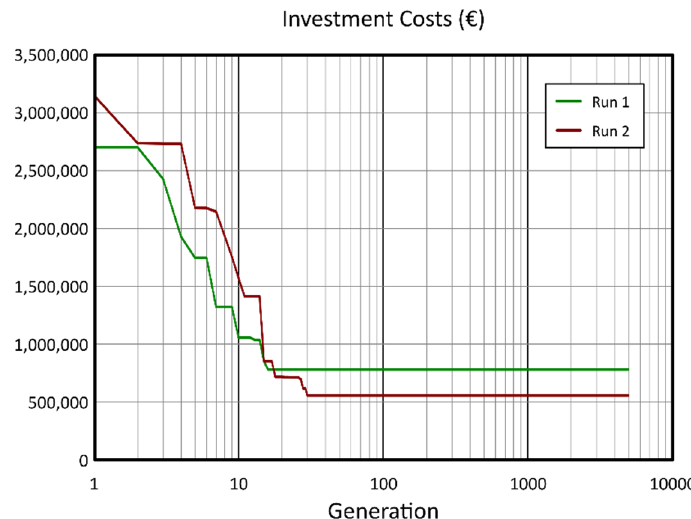
Figure 7. Evolution of the minimal investment costs for a no-flooding situation as a function of the generation. The scenario used corresponds to combining tanks and pipes (35T + 35C) under two different simulations.